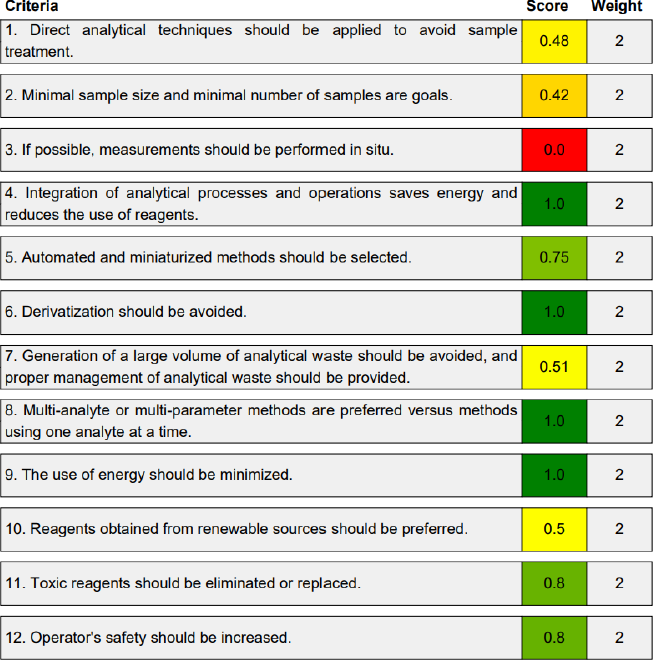
Figure 6. Greenness report sheet for the proposed method calculated by using 12 different greenness criteria with the AGREE software. Table 4. Comparison between the proposed method and previously reported methods for the de- termination of FAV.